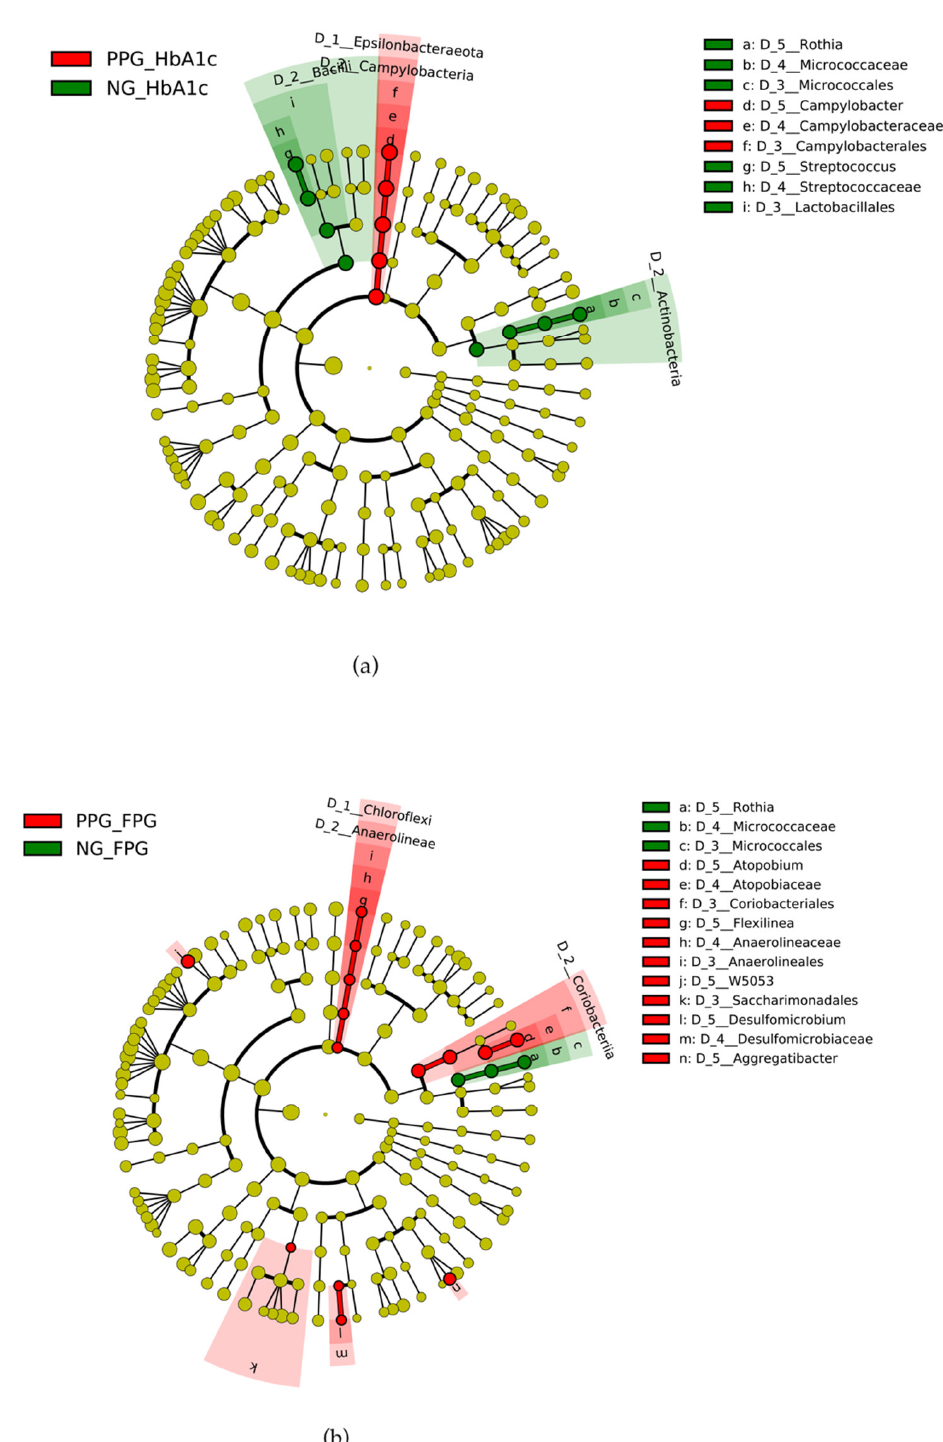
Figure 4. Cladograms from LEfSe analysis of saliva bacterial genera between PPG HbA1c and NG HbA1c ( a ) and between PPG FPG and NG FPG ( b ). The red and green labels show the genus of bacteria with significantly higher abundance in PPG and NG groups, respectively.